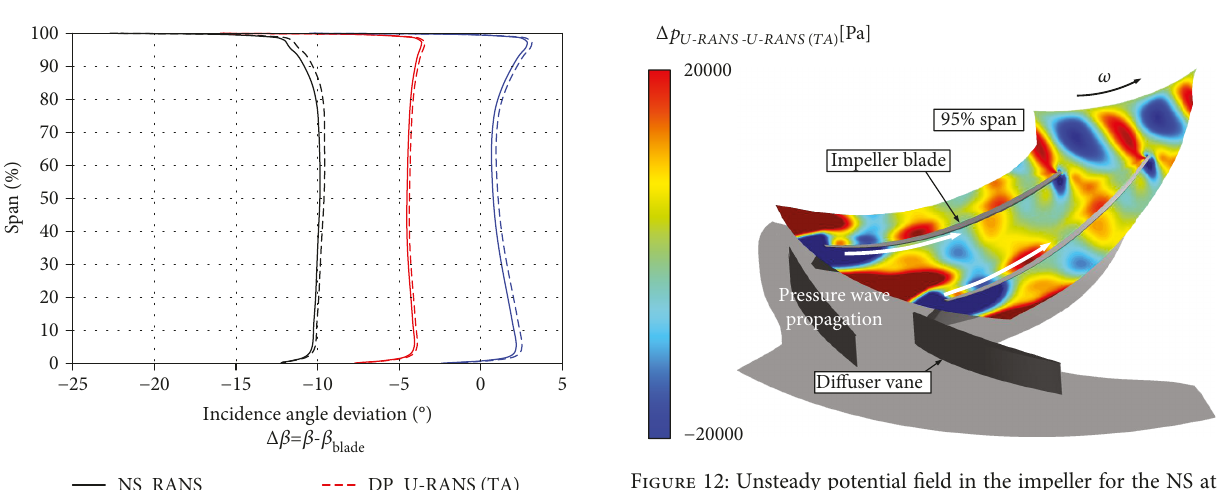
Figure 12: Unsteady potential fi eld in the impeller for the NS at a certain point in time.